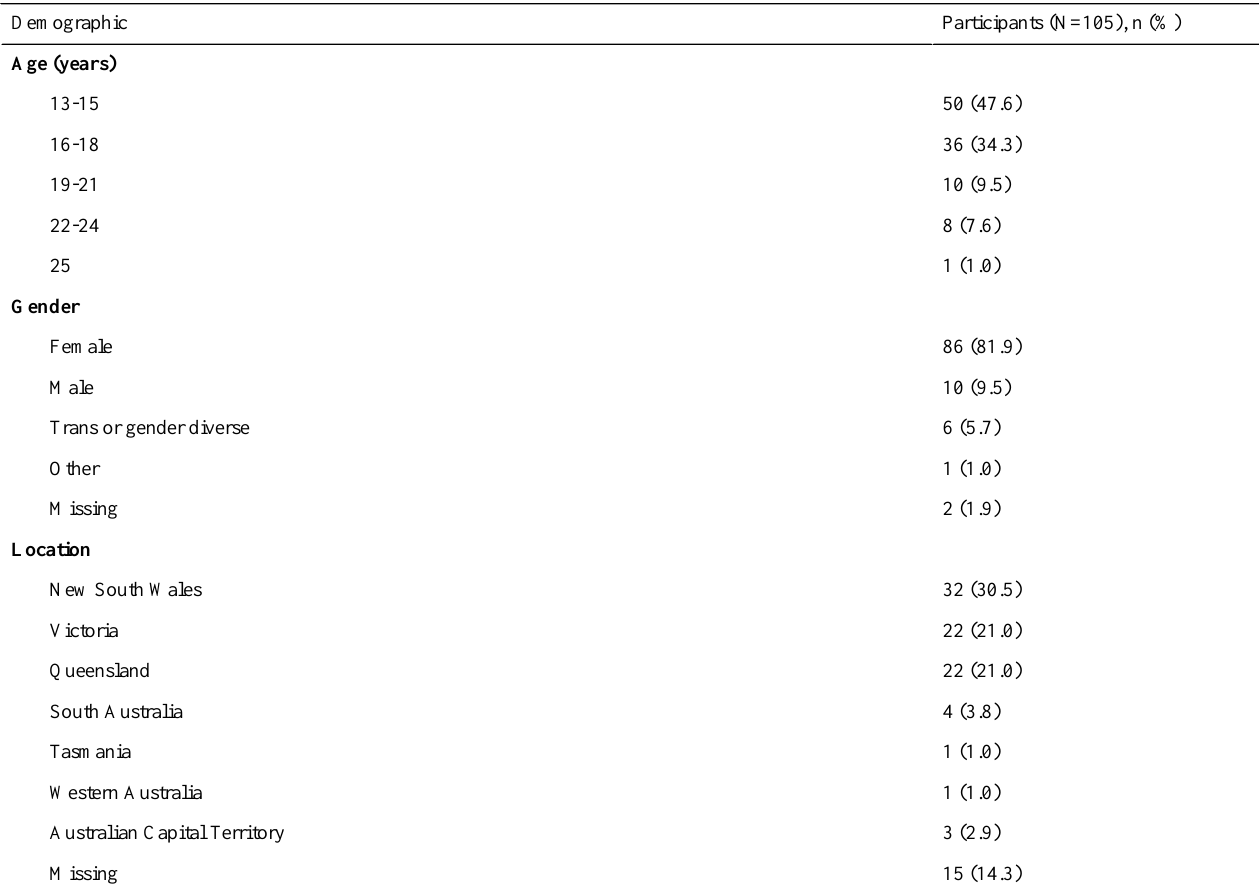
Table 1. Participant demographics and response